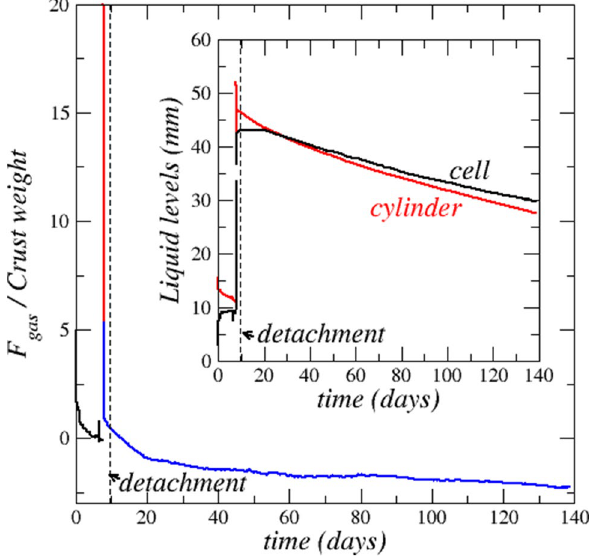
Figure 4. Evolution of the force exerted on the crust due to the gas pressure difference between the crust top and bottom. The force is scaled by the crust weight. The inset shows the variation of water levels in the cell (black) and the adjacent cylinder (red). Levels are measured from the bottom (top of polymeric base in Fig.